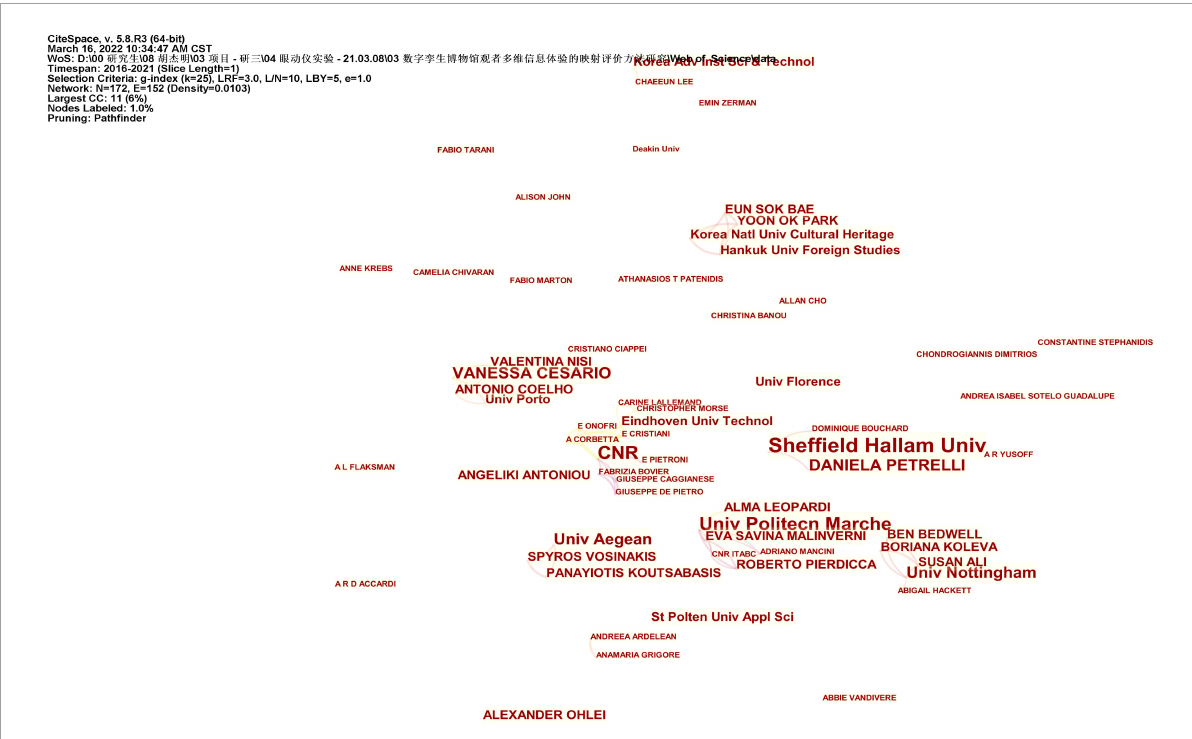
them, the key word “cultural heritage” has the most intensive collinear network, with a total frequency of 26 times.